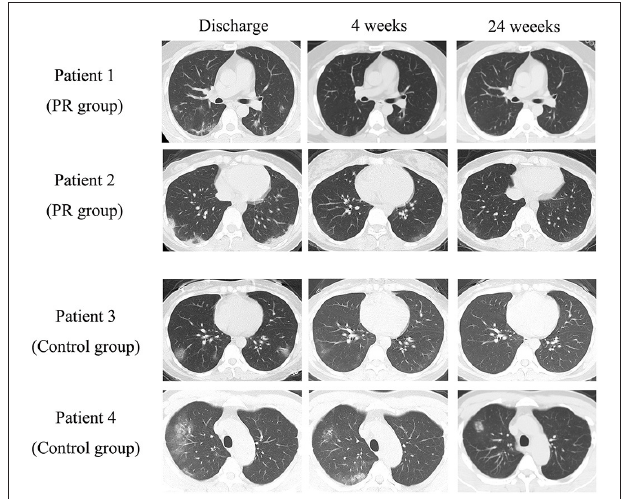
FIGURE 2 | Typical CT imaging of each